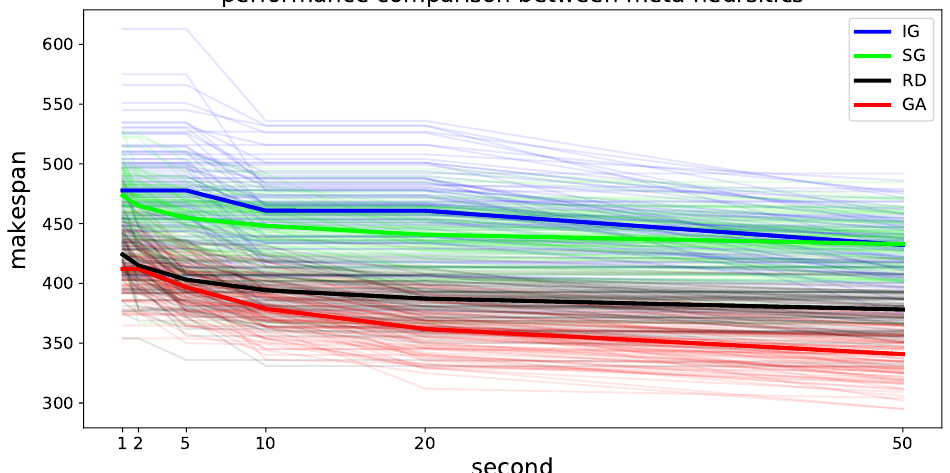
Figure 6. Makespan for 4 algorithms in the environment with 5 robots and 30 tasks. The initial positions are random and workload is bounded by 20. We plot 100 sample results in light colors and the average in thick lines. The X -axis represents the real-time for 1, 2, 5, 10, 20, and 50 s. The lower the value, the better